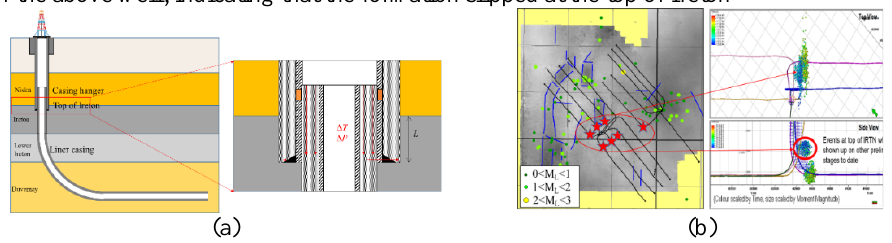
Fig. 6. Well structure and micro-seismic during fracturing: (a) L is presented the distance between the casing shoes and the top of Ireton, (b) Micro-seismic distribution